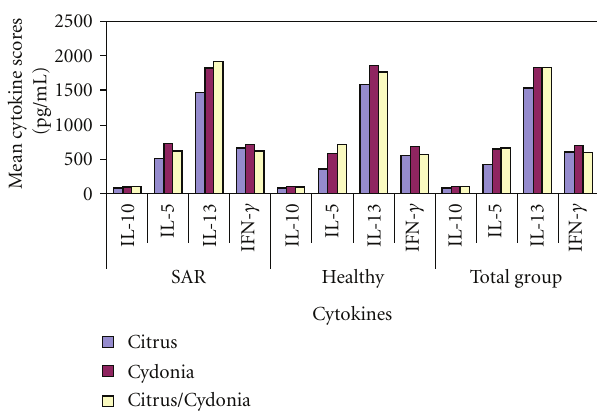
Figure 3: Summary of di ff erences in mean scores after one-day PBMC cultures in the SAR group, healthy group, and total group.